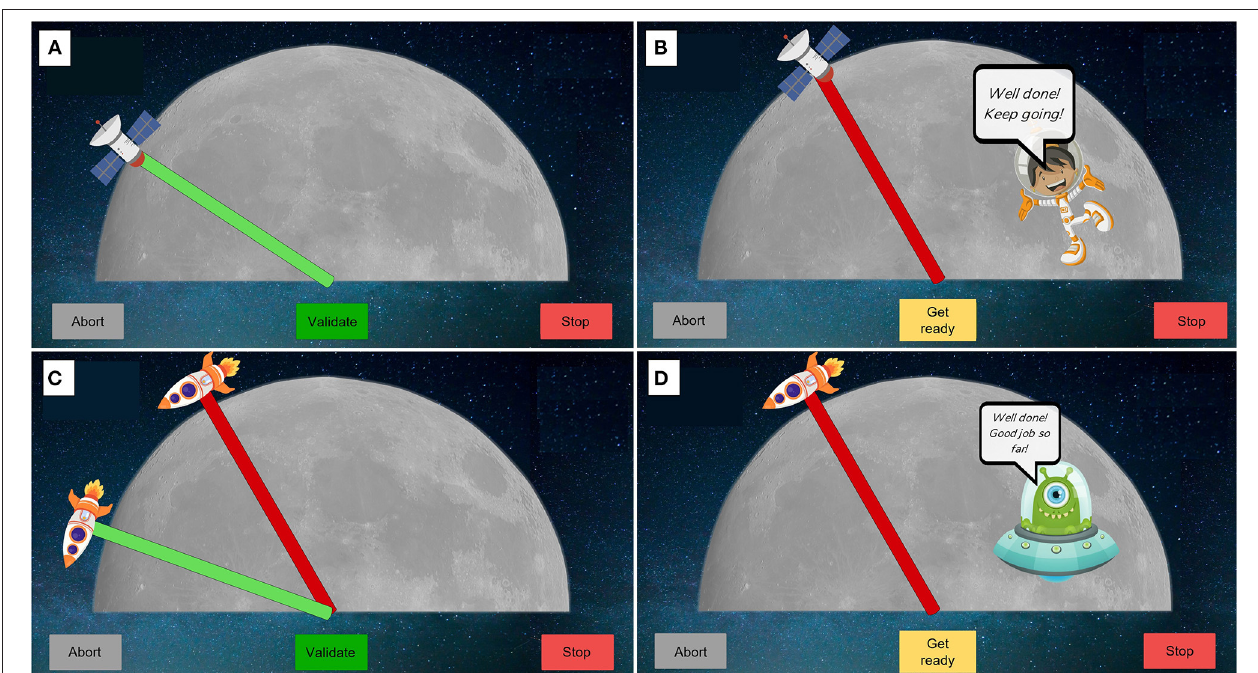
FIGURE 2 | Visualization of assessments interfaces. (A,B) Passive position sense assessment. Participants need to indicate using the green needle with a satellite, their perceived finger position. The finger is first moved to the starting position (red) by the robot and then to a position in flexion. (C,D) Active position sense assessment. Participants need to move their finger as accurately as possible from a starting position (red needle) to the position of the green needle. The green needle stays visible until participant clicks “validate” button to proceed to next trial, when his/her finger is moved to the starting position. An encouraging character is displayed twice per session when the finger is moved to the starting position (B,D) . A “abort” and emergency stop buttons are always displayed on the GUI to allow to quit the assessment if needed.